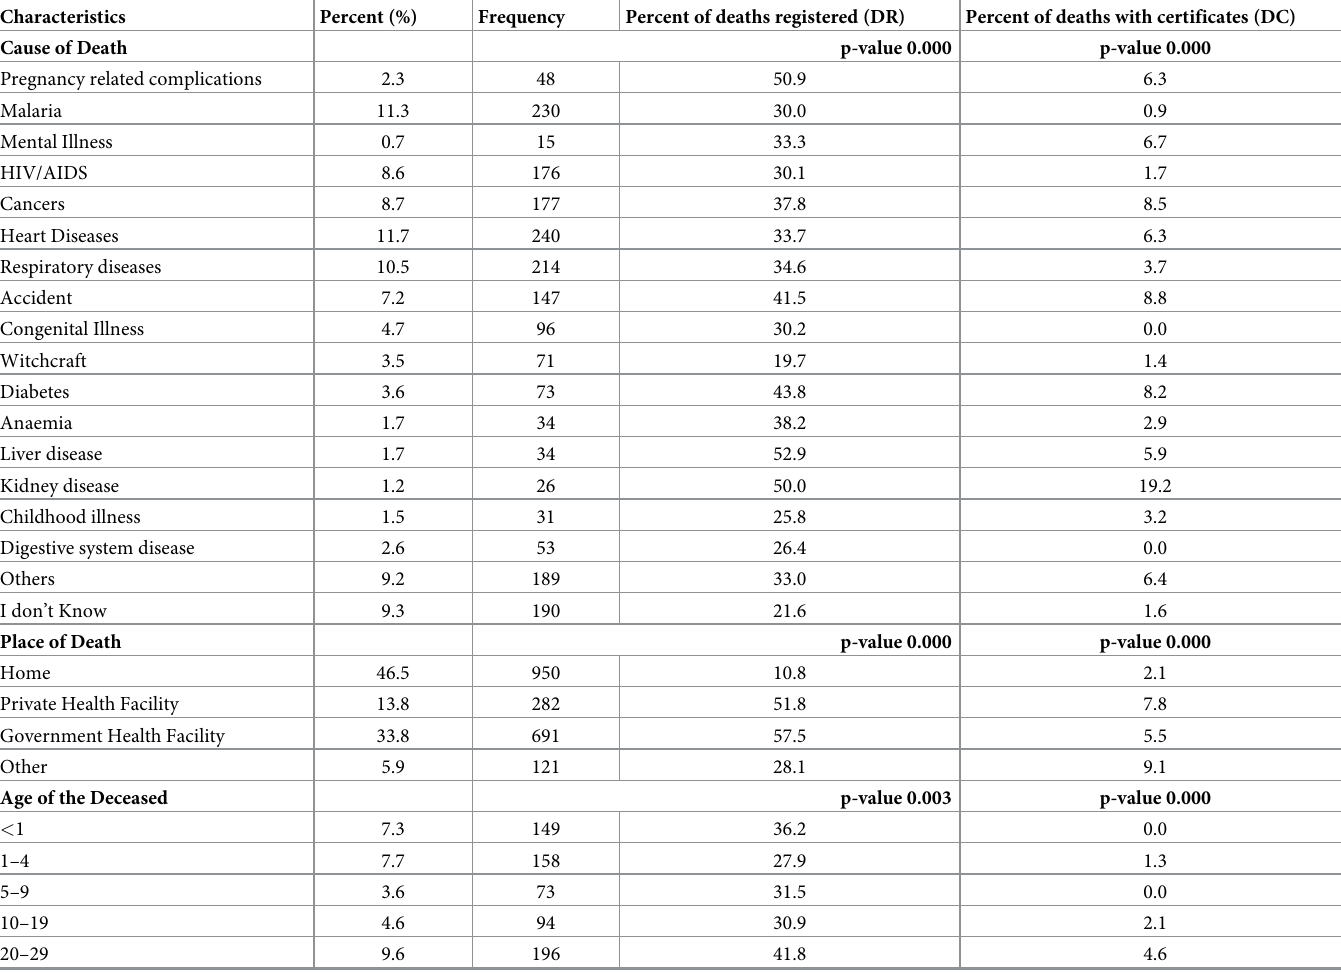
Table 3. Percent distribution of characteristics of deceased persons by death registration &